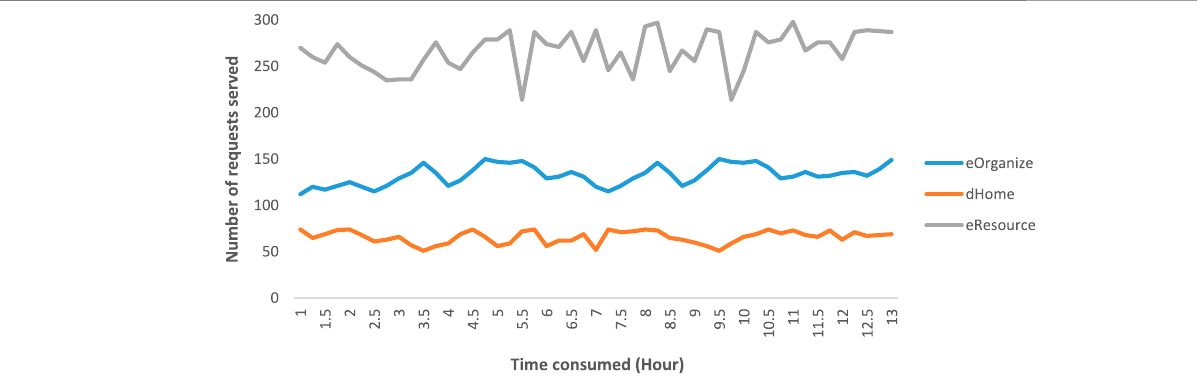
FIGURE 3 | Number of energy requests served.